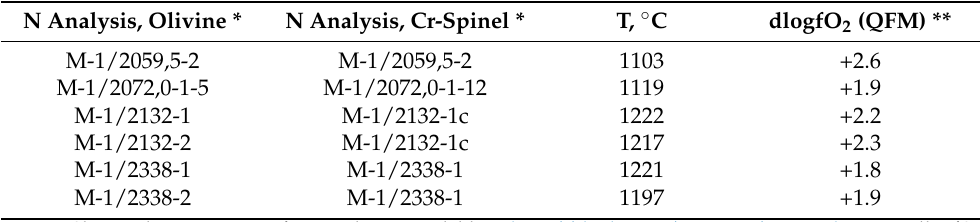
Table 3. Olivine–Cr-spinel oxythermobarometry of ultramafic rocks of the Magma Feeder Channel. N Analysis, Olivine * N Analysis, Cr-Spinel